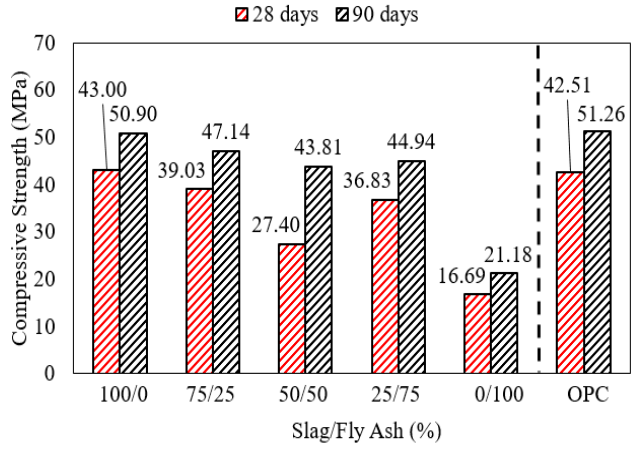
Figure 11. Strength development of mortar with an AASF binder. NaoH concentration = 8% for slag:fly ash ratios = 100/0, 75/25, and 50/50. NaOH concentration = 12% for the 25/75 ratio [28].